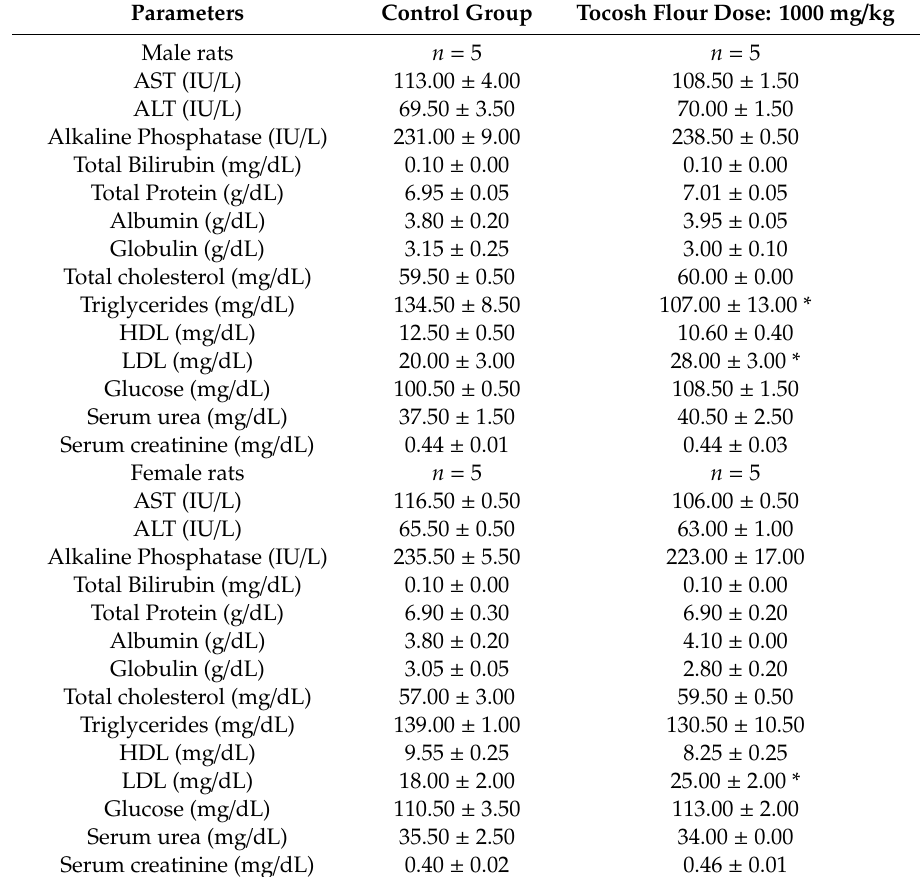
Table 2. Biochemical parameters of rats after administration of repeated oral doses of tocosh flour at doses of 1000 mg / kg for 28 days.